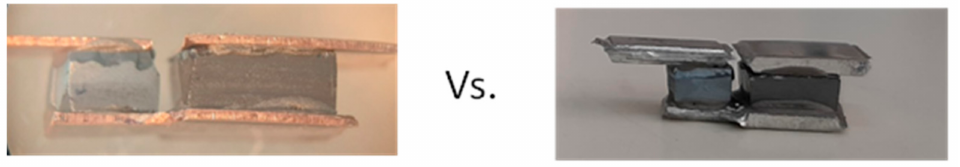
Figure 3. Copper and aluminium connectors implemented in silicide-tetrahedrite TE pairs.